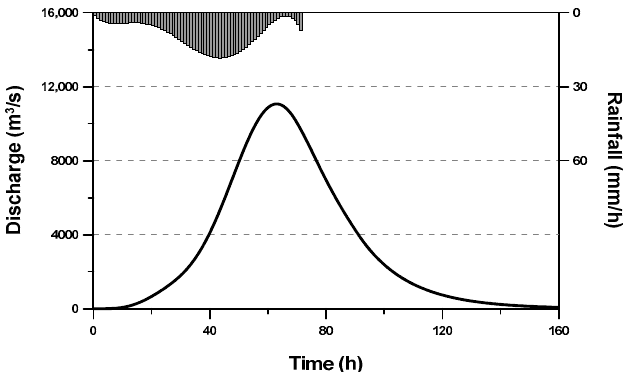
Figure 5. The inflow hydrograph determined for the operation of Peace Dam, which was derived by applying the 200-year 72-h probable rainfall.